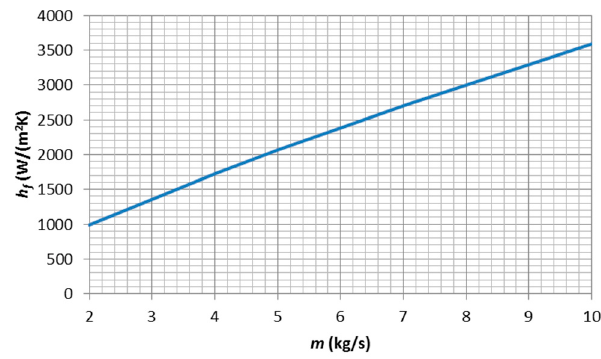
Figure 10. Convective heat transfer coefficient as a function of mass flow in the